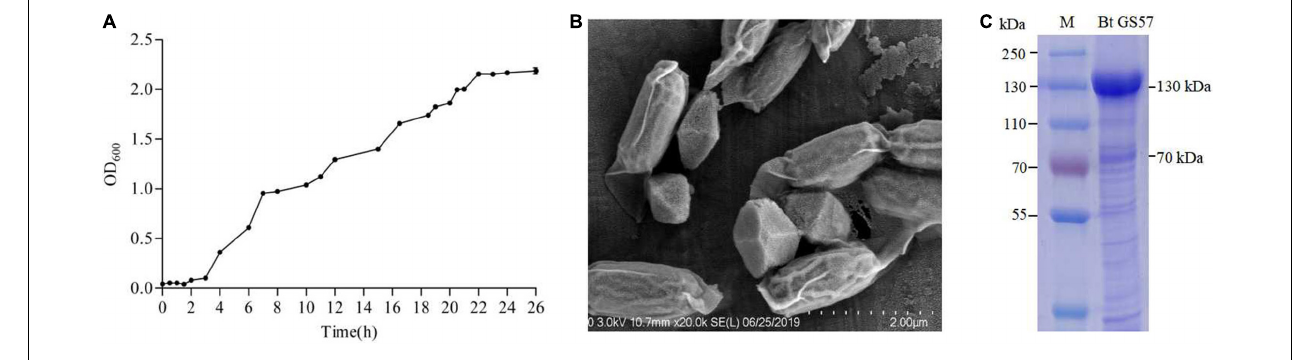
FIGURE 1 | General characteristics of Bt GS57. (A) The growth curve of Bt GS57. (B) Scanning electron microscope (SEM) analysis of Bt GS57 spores and parasporal crystals. (C) SDS-PAGE analysis of spore-crystal suspension of Bt GS57: lane M, molecular mass standard; lane 1, Bt GS57.